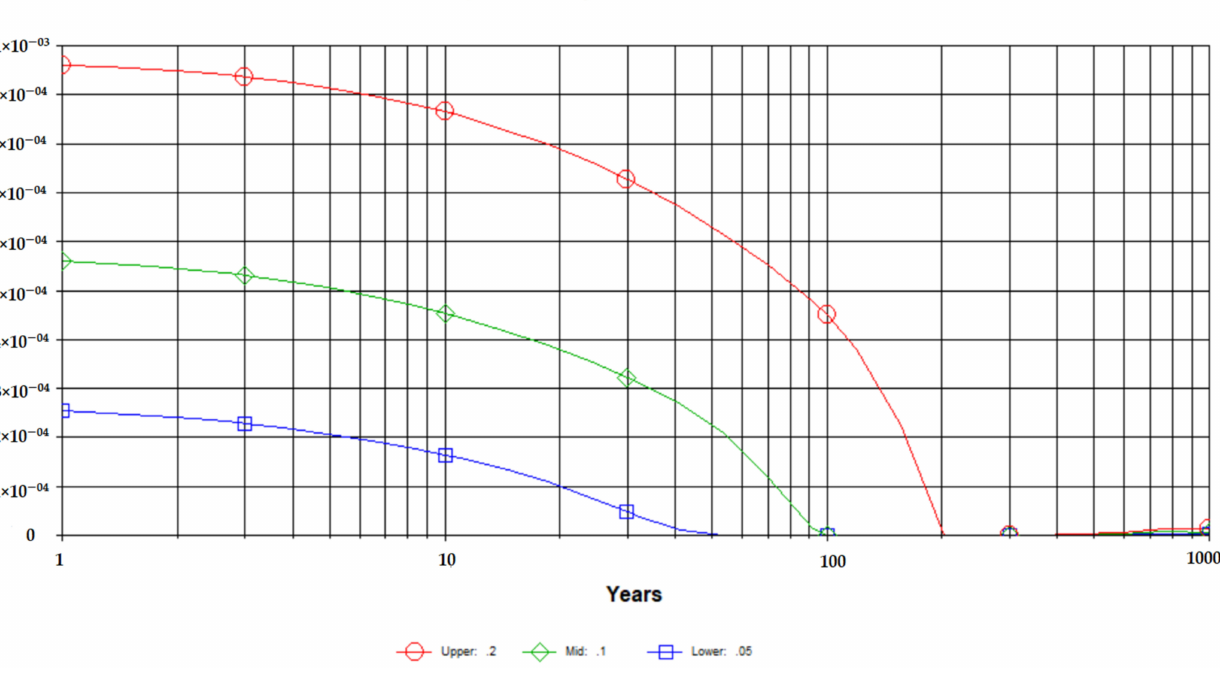
Figure 8. Cancer risk as a function of time for all radionuclides summed and all exposure pathways summed using the sensitivity analysis on the thickness of the contaminated area.